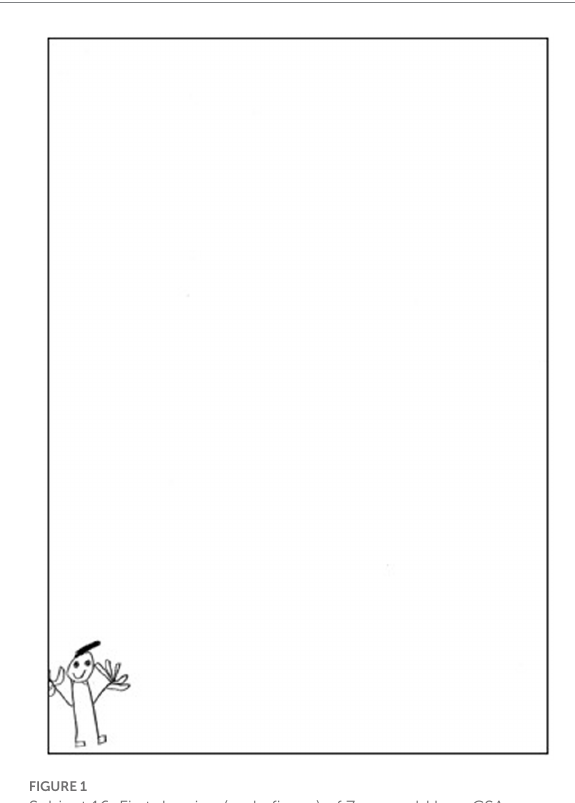
FIGURE 1 Subject 16: First drawing (male figure) of 7-year-old boy. CSA indicators: Indicator 1 (omission of body), Indicator 4 (dot/shaded eyes), Indicator 7 (pre-schematic drawing) and Indicator 8 (small figure